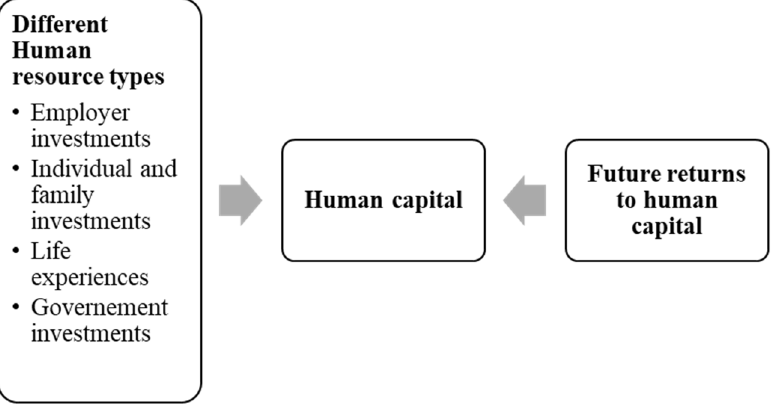
Figure 1. Different sources of HR investments. Source: own illustration based on Stroombergen et al. (2003).